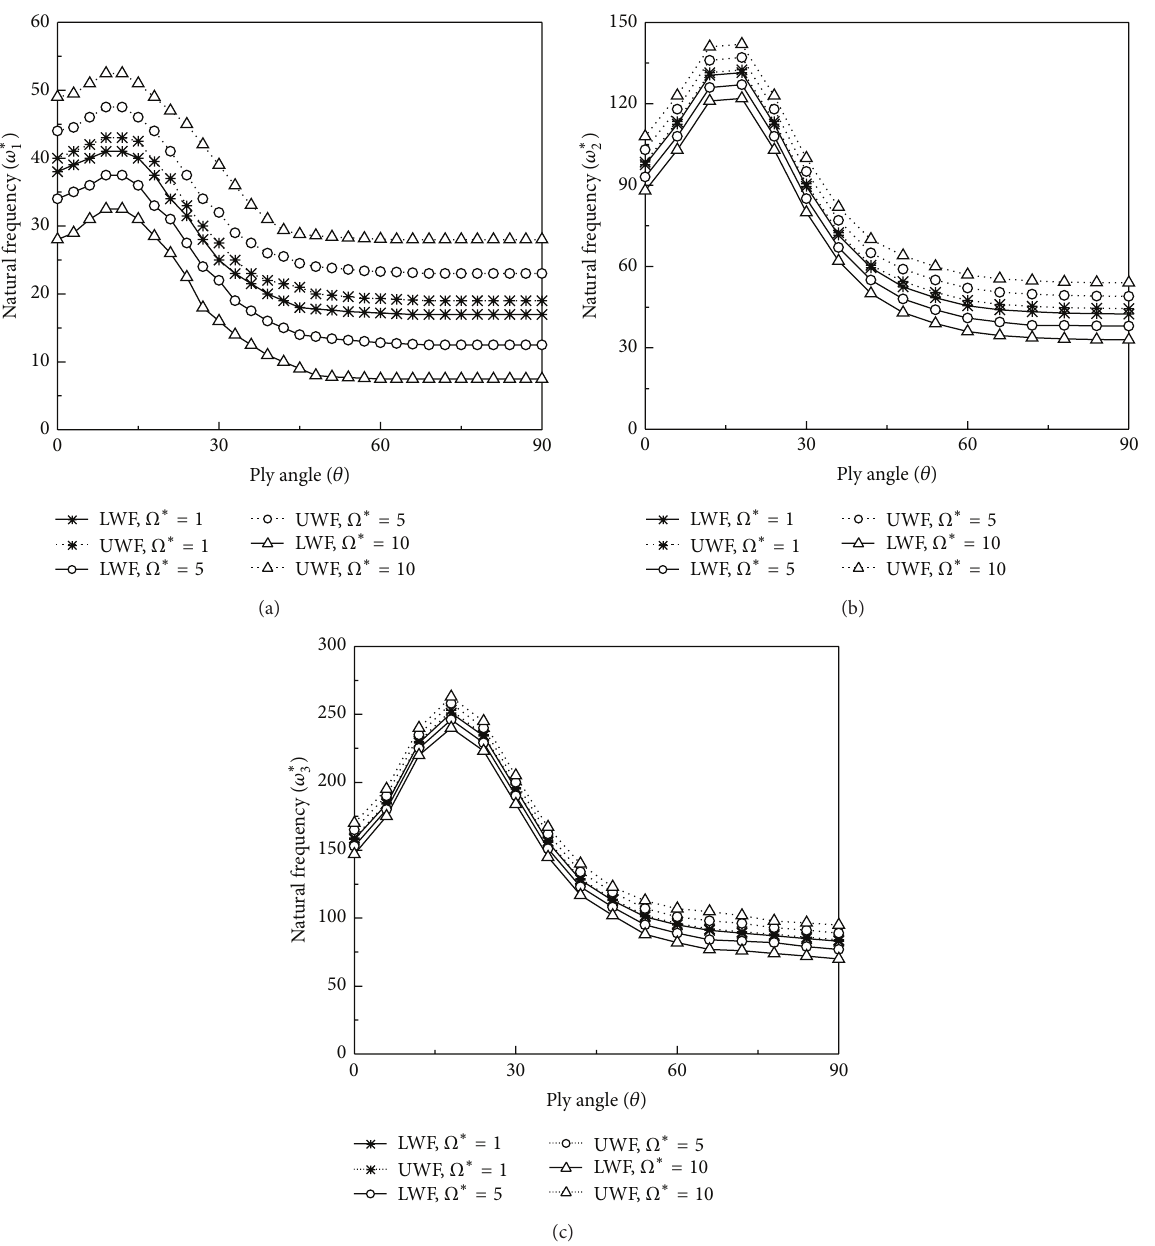
Figure 9: The first three natural frequencies versus ply-angle for different rotating speeds ( 𝑉 𝑠 = 0.24 ; 𝜃 = 30 ∘ ; 𝑇 = 50 ∘ C; 𝜀 0 = 0.067 ).